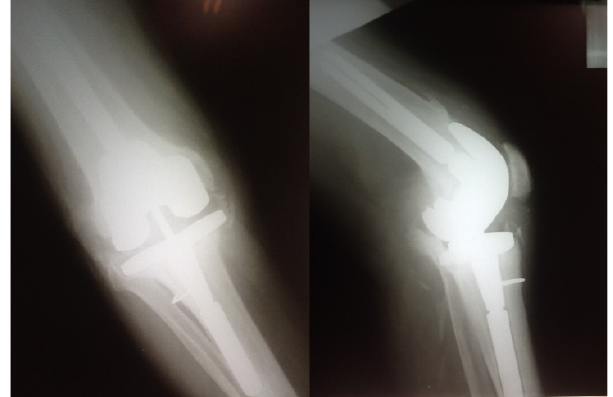
Figure 2. X-Ray of one-stage TKA